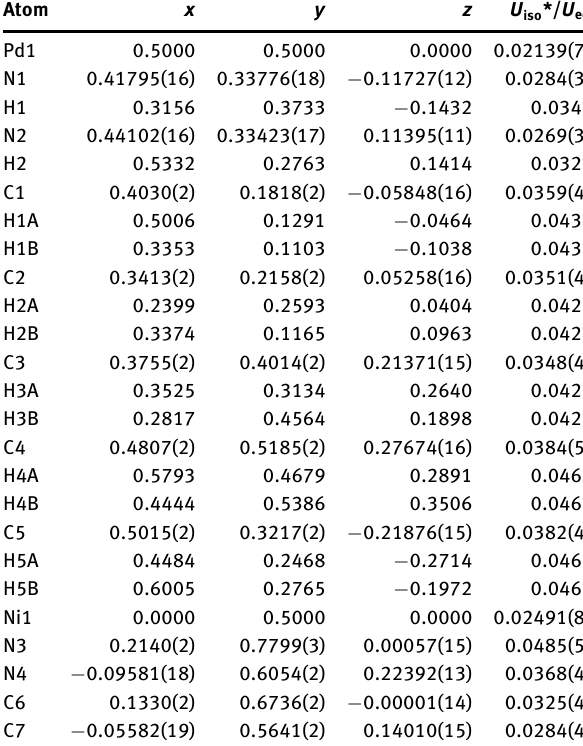
Table 2: Fractional atomic coordinates and isotropic or equivalent isotropic displacement parameters (Å 2